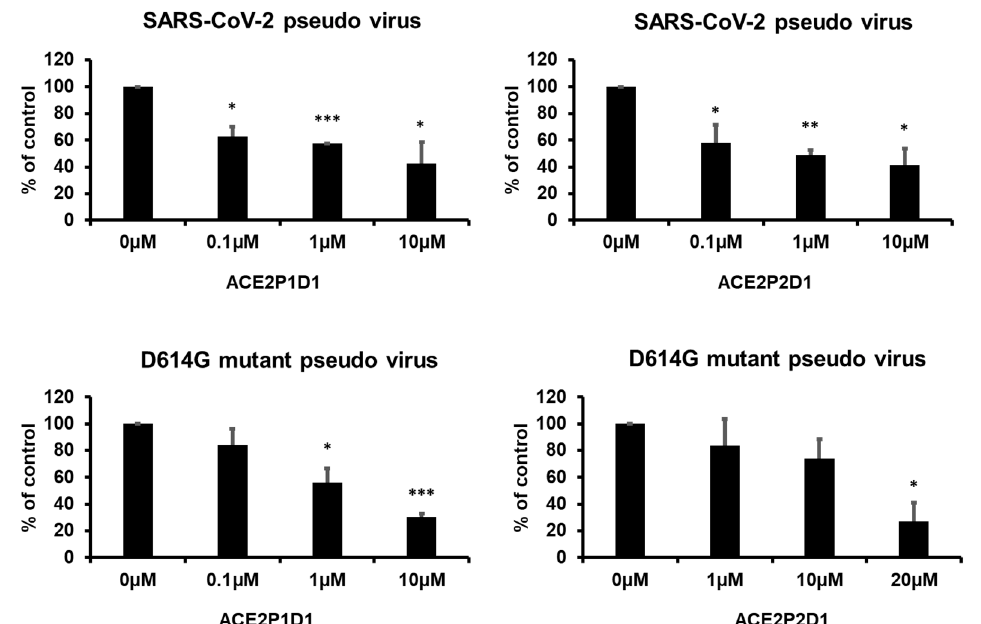
Figure 3. ACE2P1 and ACE2P2 dimers prevented SARS-CoV-2 pseudovirus infection of human cells. ( a , b ) NCI-H1299 cells were pretreated with PBS or various concentrations of ACE2P1D1 or ACE2P2D1 for 1 h and then infected with pseudovirus for 24 h. Infection was detected with luciferase reporter assay at 72 h. ( c , d ) NCI-H1299 cells were pretreated with PBS or various concentrations of ACE2P1D1 or ACE2P2D1 for 1 h and then infected with D614G mutant pseudovirus for 24 h. Infection was detected with luciferase reporter assay at 72 h. Each bar represents the mean + standard deviation ( n = 2/group). * p < 0.05, ** p < 0.01, and *** p < 0.001.